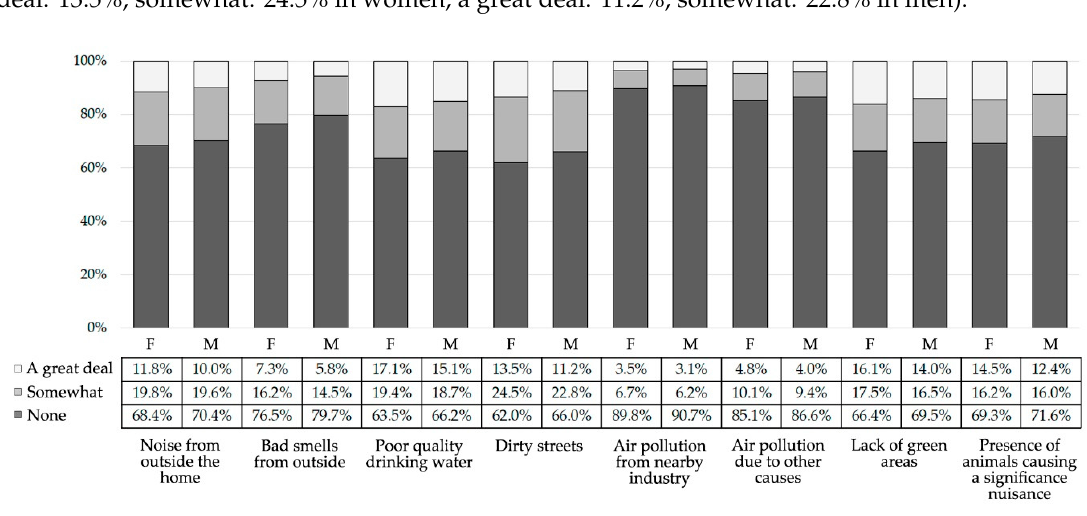
Figure 1. Perception of environmental problems of people aged from 16 to 64 years in Spain (N = 48,505) (2006–2017). F: female; M: male.